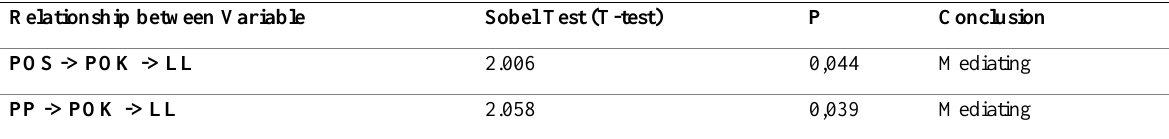
Table 7: Indirect Influence (Mediation) between